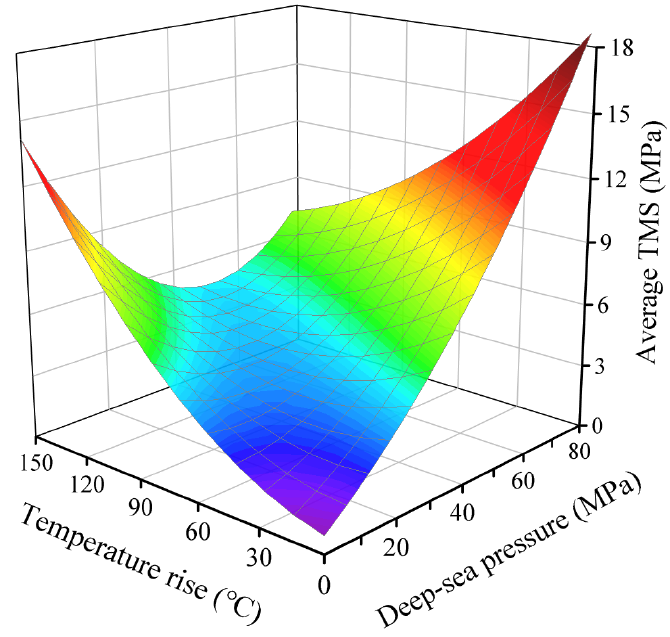
Figure 12. Average TMS in the SIS of the DSOF motor variation with seawater pressure and tempera- ture